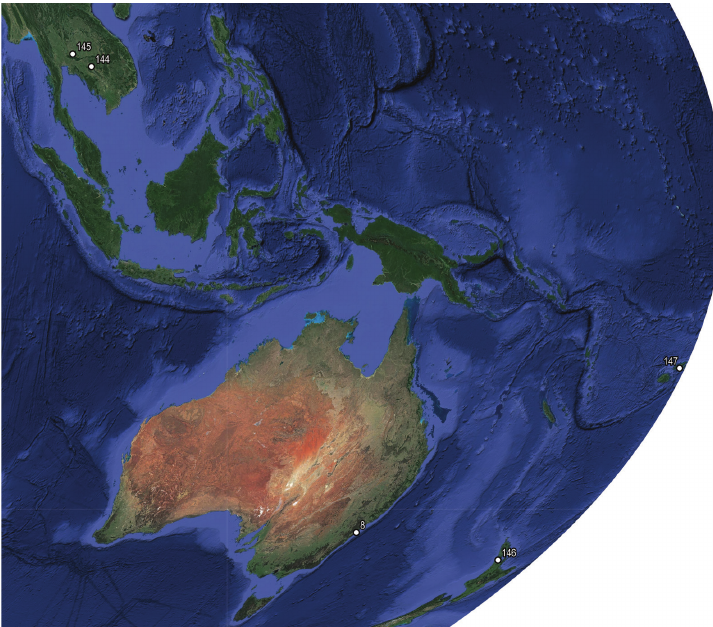
Figure 7 Map of Southeast Asia and